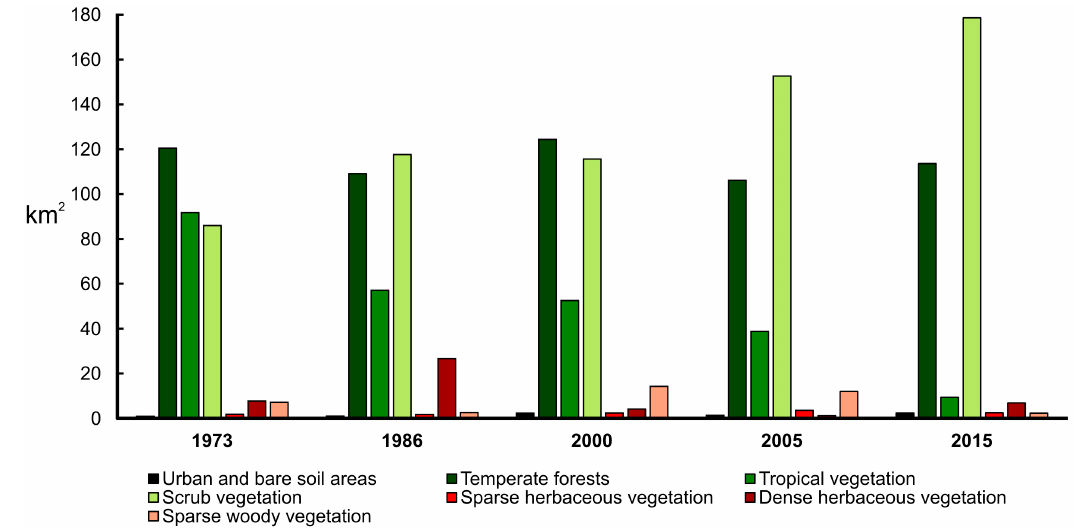
Figure 3. Occupied area (km 2 ) for each land use-cover category over the study period, Natural Protected Area Altas Cumbres polygon. Victoria, Tamaulipas, Mexico.